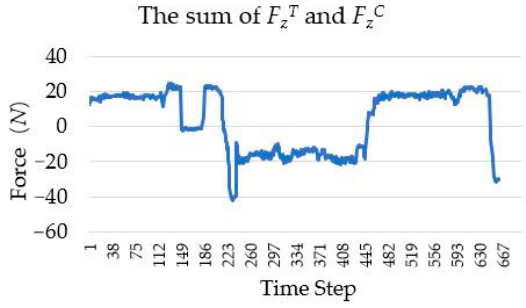
Figure 26. The change curve of the traction and contact forces in the drawer switch experiment: ( a ) Traction force F T ; ( b ) contact force F C . Z Z